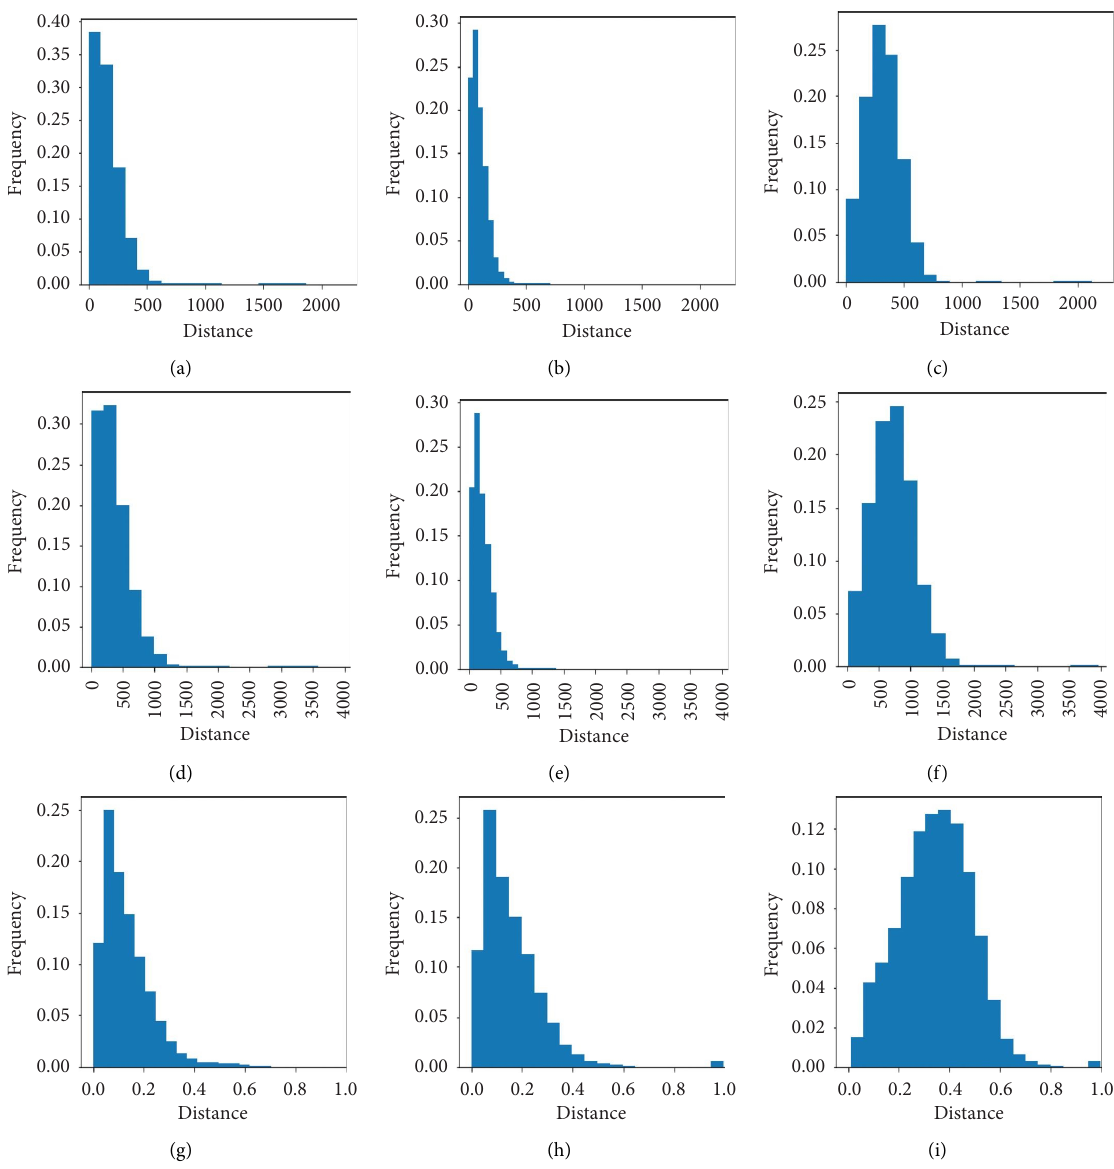
Figure 4: Histograms of diferent distances for proposed feature vector f vectors and y label denotes the frequency of the corresponding distance values in all the calculated distances. First column: distances between windshear cases. Second column: distances between non-windshear cases. Tird column: distances between windshear and non-windshear cases. Top row: histograms of the Euclidean distance. Second row: histograms of the city block distance. Bottom row: histograms of the Bray–Curtis